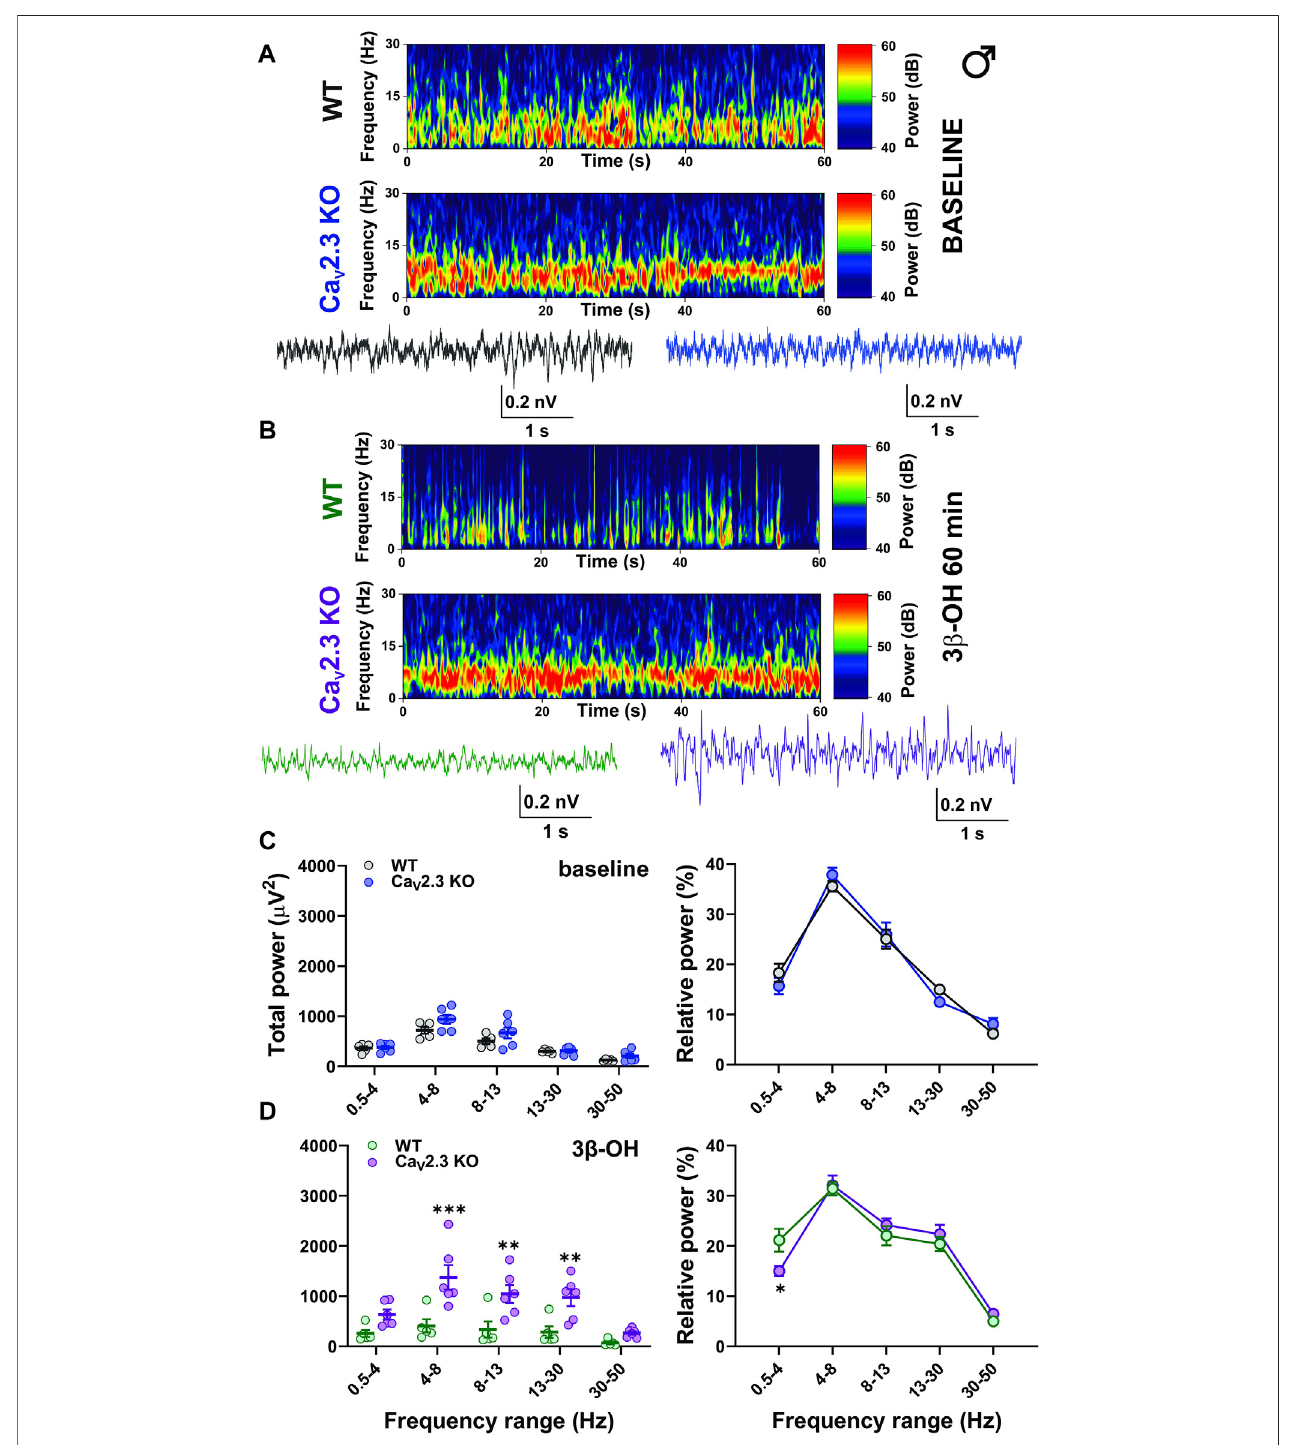
FIGURE 7 | The effects of 3 β -OH on EEG in male WT and Ca V 2.3 KO animals at the time point of 60 min after i.p. injections of 80 mg/kg of 3 β -OH. (A) Representative baseline heat map from a male WT (top) and a Ca V 2.3 KO (bottom) animal with the representative EEG traces (WT, black; Ca V 2.3 KO, blue). (B) Representativeheatmap froma maleWT (top) and a Ca V 2.3 KO (bottom) animalwith therepresentativeEEG traces (WT, green; Ca V 2.3 KO, purple) 60 min after 3 β -OH. (C) Total power during baseline (left) and relative baseline power (right). (D) Total power (left, two-way RM ANOVA: interaction F 4,36 = 5.86, p = 0.001; genotype F 1,9 = 11.49, p = 0.008; frequency F 4,36 = 19.49, p < 0.001, Š ídák ’ s multiple comparisons test presented) and relative power (left, two-way RM ANOVA: interaction F 4,36 = 2.09, p = 0.103; genotype F 1,9 = 1.84, p = 0.208; frequency F 4,36 = 61.56, p < 0.001, Š ídák ’ s multiple comparisons test presented) 60 min after 3 β -OH. N = 5 animals in WT group and N = 6 animals in Ca V 2.3 KO group. * p < 0.05, ** p < 0.01, *** p < 0.001.